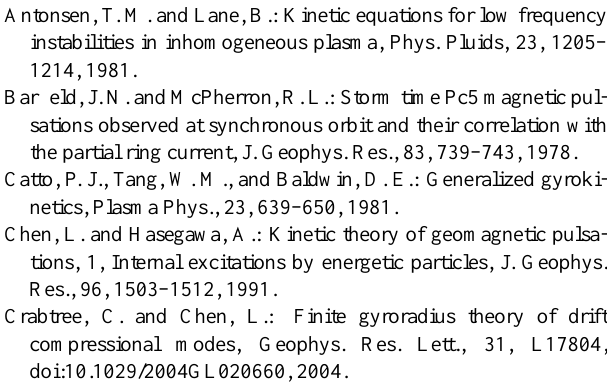
Considering the marginal instability case when 0 <1 (cid:28) 1 , k y = k ∗ and k k = k ∗ , the characteristic radial wavelength k y scales